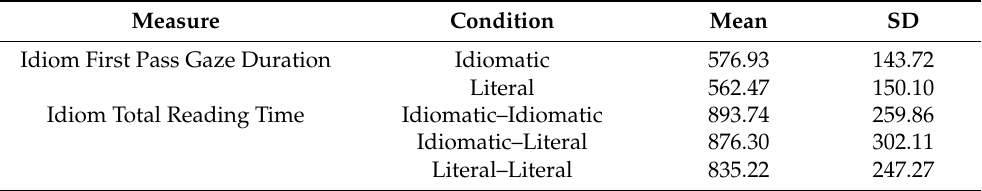
Table 4. Subject ‐ aggregated means and standard deviations (in milliseconds) for raw Idiom First Pass Gaze Duration and raw Idiom Total Reading Time (Experiment 1).